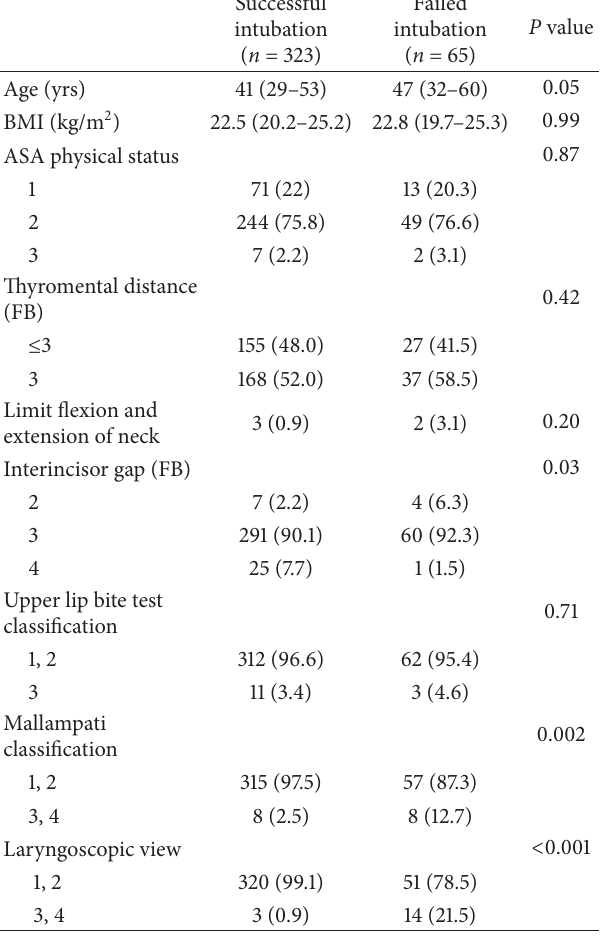
Table 1: Patient characteristics and airway assessment details.